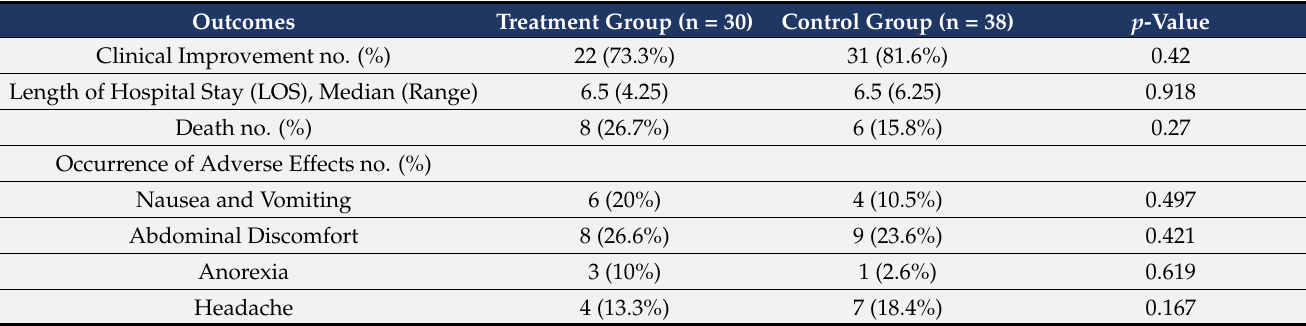
Table 4. Comparison of outcomes between treatment and control groups.